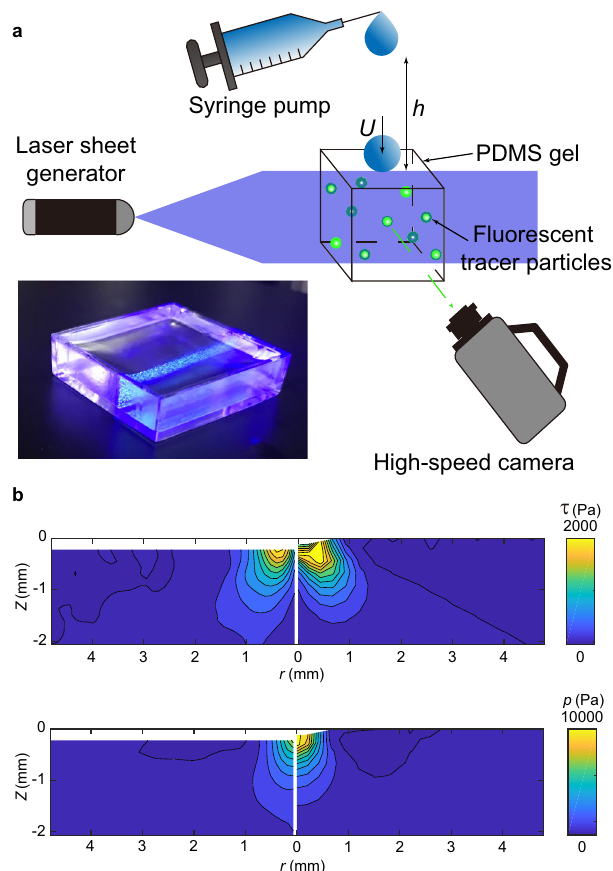
Fig. 2 High-speed stress microscopy. a A schematic showing the principle of high-speed stress microscopy. A drop falls from a height h and impacts onto the surface of a particle-embedded PDMS gel at an impact velocity U . Lower left inset: An image of the PDMS gel embedded with fl uorescent particles under the illumination of the laser sheet. b Comparison of the shear stress (top) and the pressure (bottom) induced by the impact of a steel sphere obtained from high-speed stress microscopy (left) and from fi nite element simulations (right). The diameter and the impact velocity of the steel sphere are D = 3.16 mm and U = 0.49 m/s, respectively. The stresses are measured at time t = 0.25 ms after the instant when the sphere fi rst touches the solid